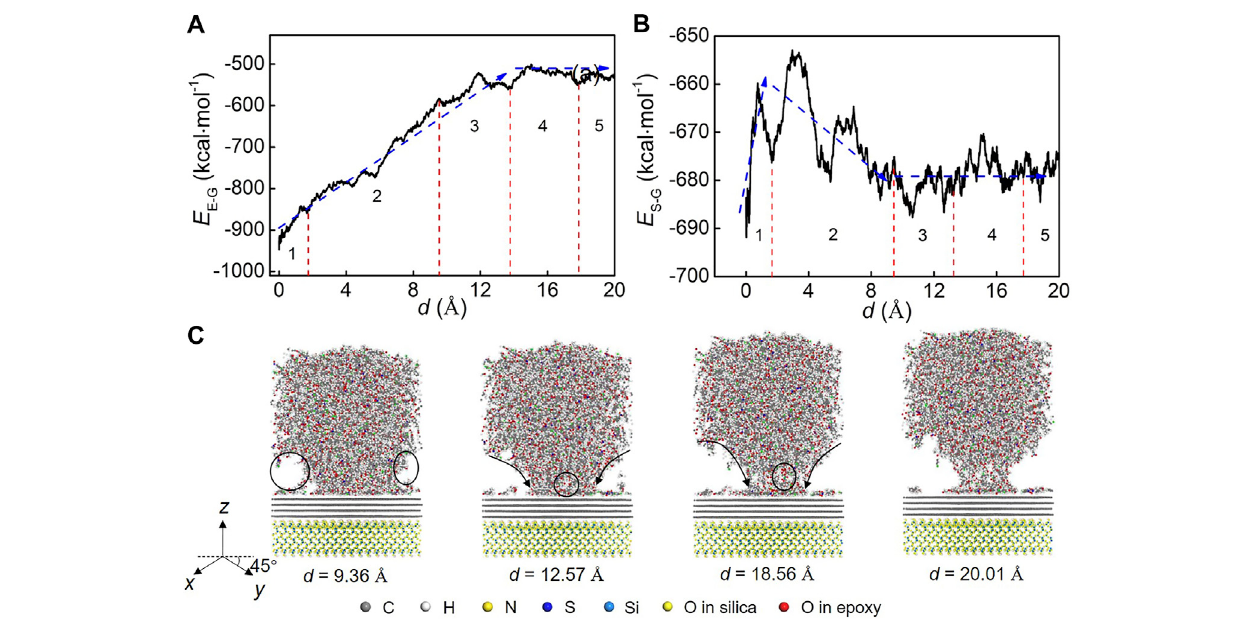
FIGURE 5 | (A) Interfacial energy variation between epoxy and graphene during pulling for the sandwiched structure with four layers of graphene coating. E E-G refers to the interfacial energy between epoxy and graphene. (B) Interfacial energy variation between silica and graphene. E S-G refers to the interfacial energy between silicaandgraphene. (C) Interfacialstructuralevolution.Thedetachment fi rstoccursattheedgeofepoxyclosetotheinterface.Thedetachmentpropagatesintotheinner and fi nally causes the debonding within the epoxy close to the interface.